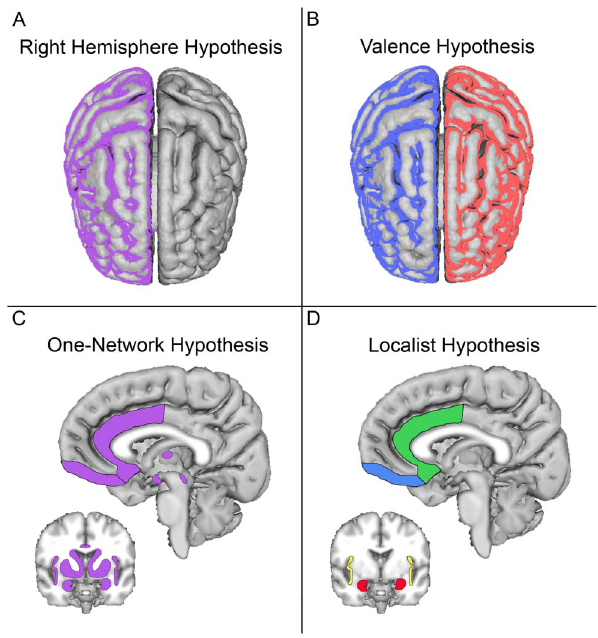
Figure 1. Four hypotheses for emotion processing in the brain have been put forward. (Figure based on [15]. The right hemisphere hypothesis (a) assumes that emotion is processed predominantly in the right hemisphere. The valence hypothesis (b) suggests the right hemisphere to be dominant in processing negative emotions and the left hemisphere to be dominant in processing positive emotions. The one-network hypothesis (c) posits that all emotions may be processed by a set of brain regions not specific to a respective emotion category, while the localist hypothesis (d) is that processing of different emotions specifically corresponds to activation in distinct brain regions. (Figure 1D). Models falling within this ‘‘localist’’ theory typically assume that discrete emotions form the smallest psychological entities at play, which cannot be broken up any further. Studies have found single brain regions to play crucial roles in either positive or negative distinct emotions: the amygdala activated in response to fear [16–18], the insula to disgust [19], the subgenual anterior cingulate cortex to sadness [20,21], and the basal ganglia to happiness [17,18].